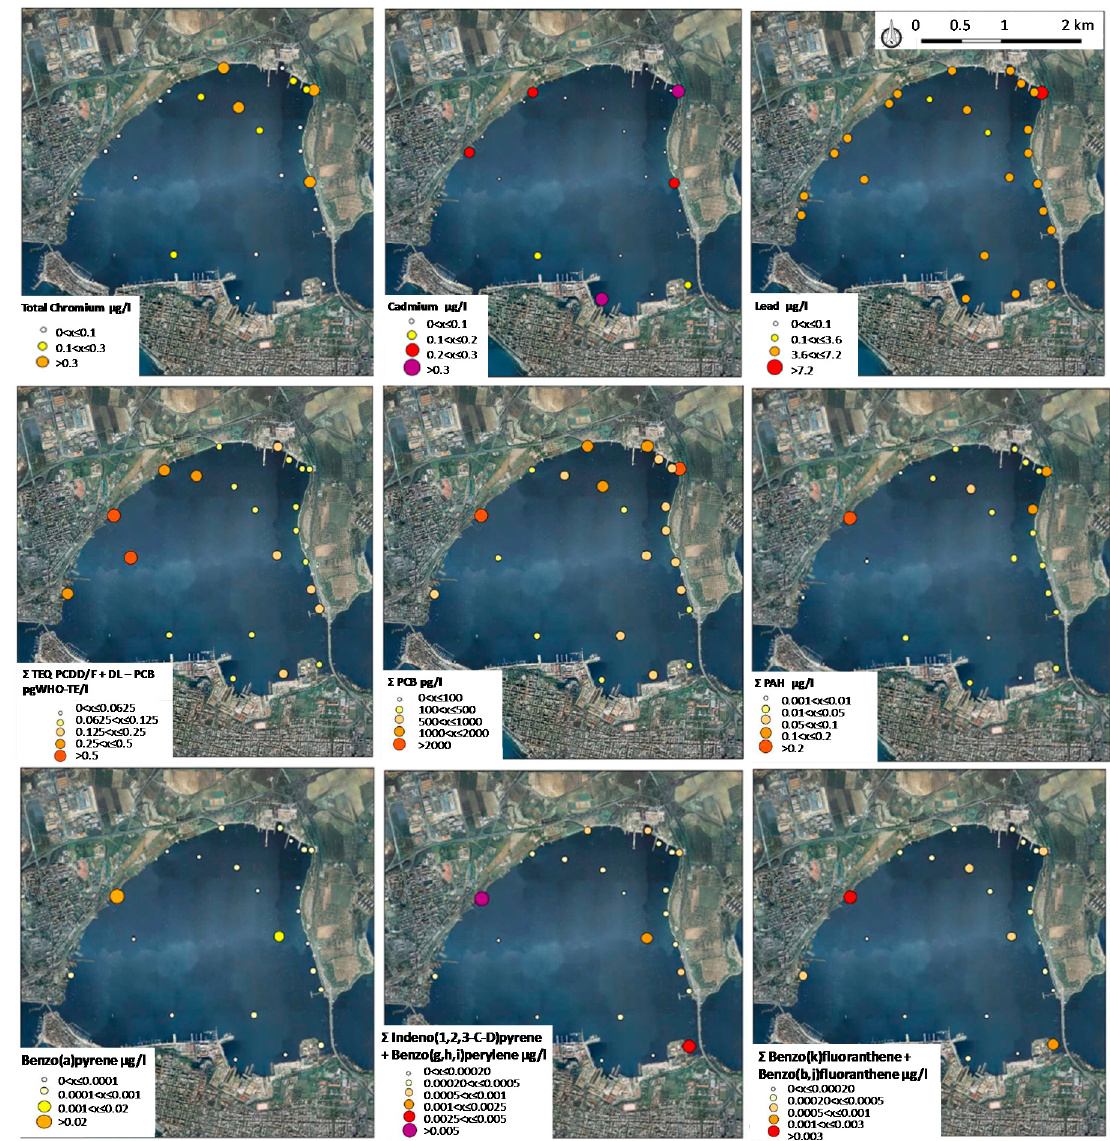
Figure 10. Analytical values of contamination in water column for heavy metals, PAHs, and PCBs (adapted from [31]).